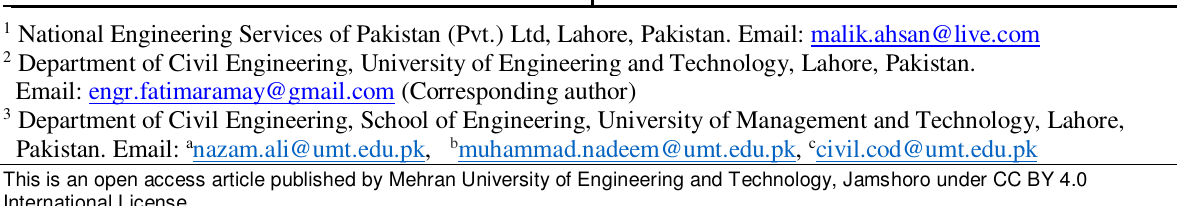
Fig. 1: Glass waste management: 1960 – 2015 Glass, due to its properties ( i.e ., taking any shape, brighter surface, resistance against abrasion)